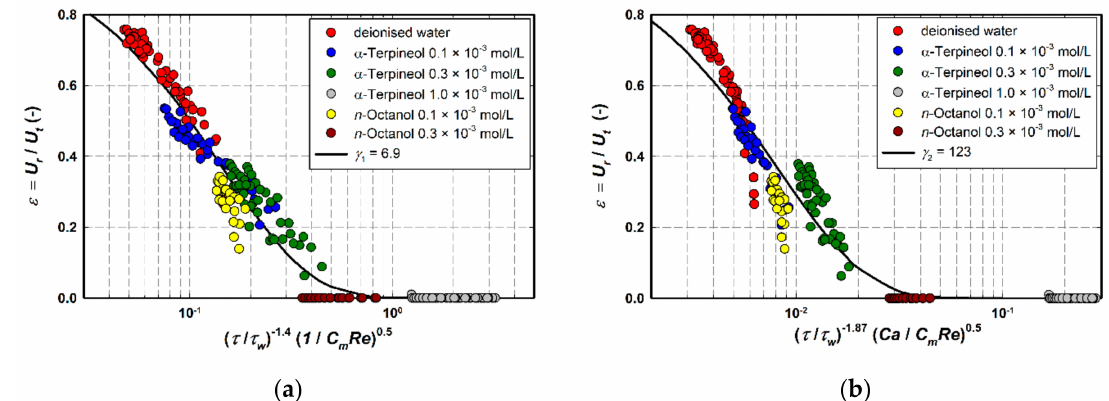
Figure 7. Prediction of the restitution coefficient for the used liquids; ( a ) expression for Equation (5); ( b ) expression for Equation